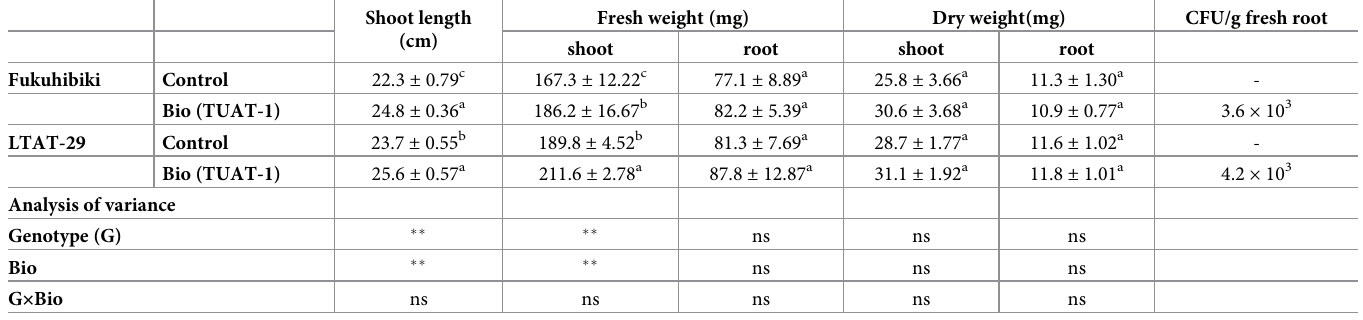
Table 1. Effect of inoculation of TUAT-1 on morphological parameters in two rice genotypes grown in nursery seedling box at 21 days after